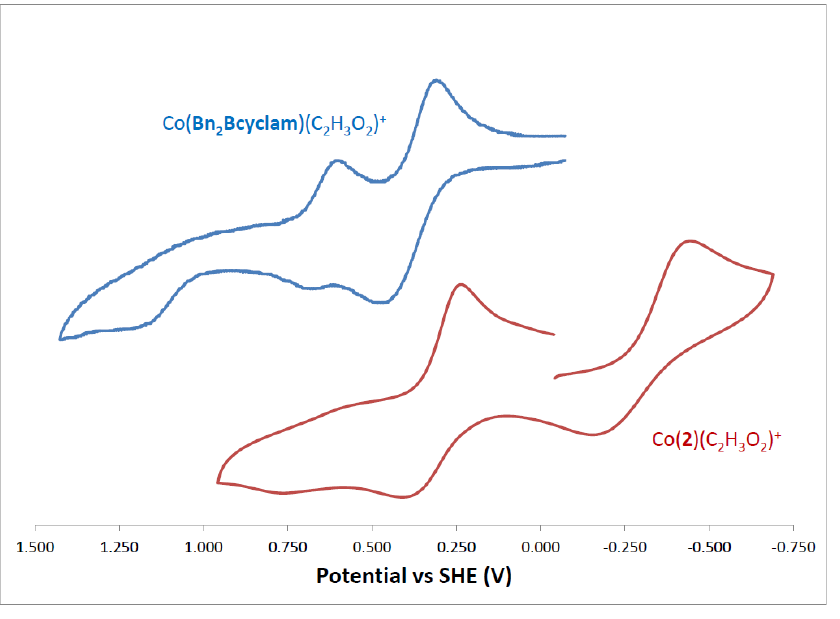
Figure 15. Cyclic Voltammograms of Co( Bn 2 Bcyclam ) and Co( 2 ) in acetonitrile at 0.001 M.